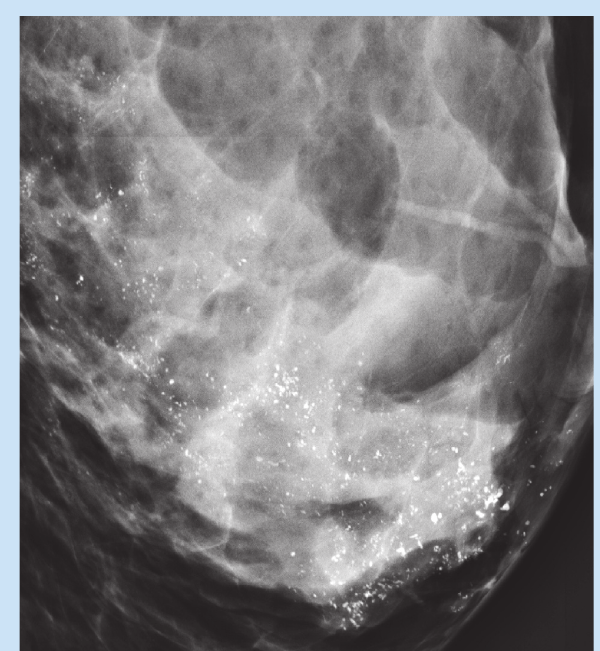
Fig. 2. A left medio-lateral oblique view demonstrating segmental diffuse increased density of the breast tissue and segmental diffuse pleomorphic calcifications of heterogeneous size, shape and